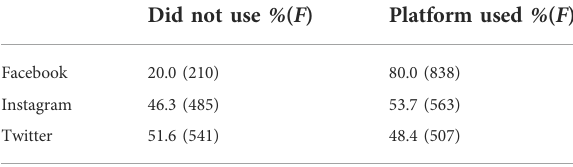
TABLE 3 Social media sources used (N = 1,048).